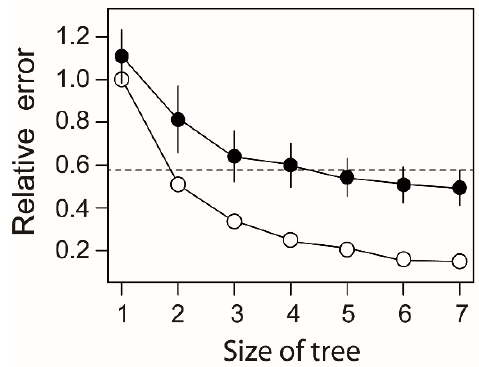
Figure 4. Variation in relative error with the size of the multivariate regression tree. Open circles indicate the relative error, and filled circles indicate the cross-validated relative error (CVRE). The vertical bars indicate one standard error for the CVRE, and the dashed line indicates one standard error above the minimum cross-validated relative error.